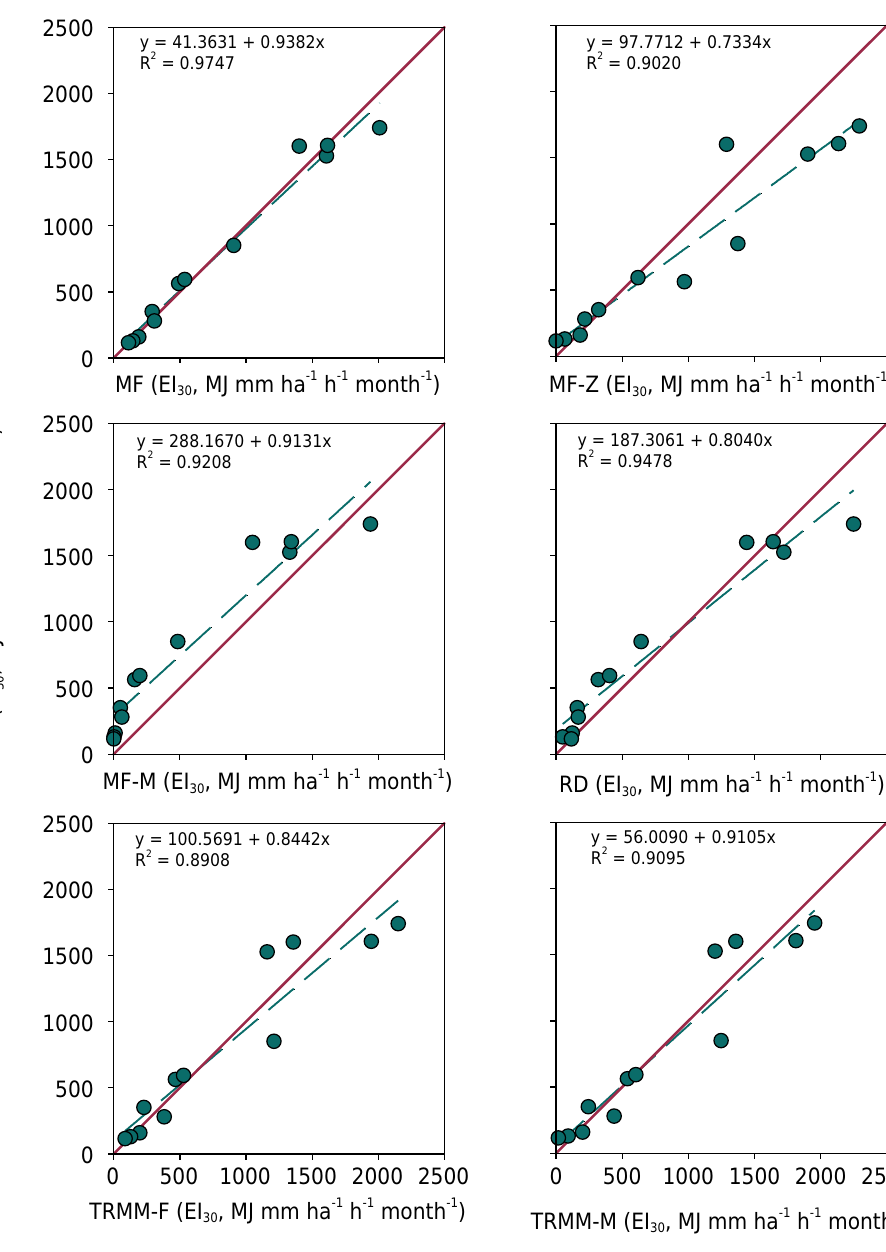
Figure 4. Comparison between standard (WS) and other estimated rainfall erosivity (EI 30 ) methods. WS: Wischmeier and Smith; MF: modified Fournier; MF-Z: modified Fournier by Zhang; MF-M: modified Fournier by Men; RD: Rainfall Disaggregation; TRMM-F: TRMM-M